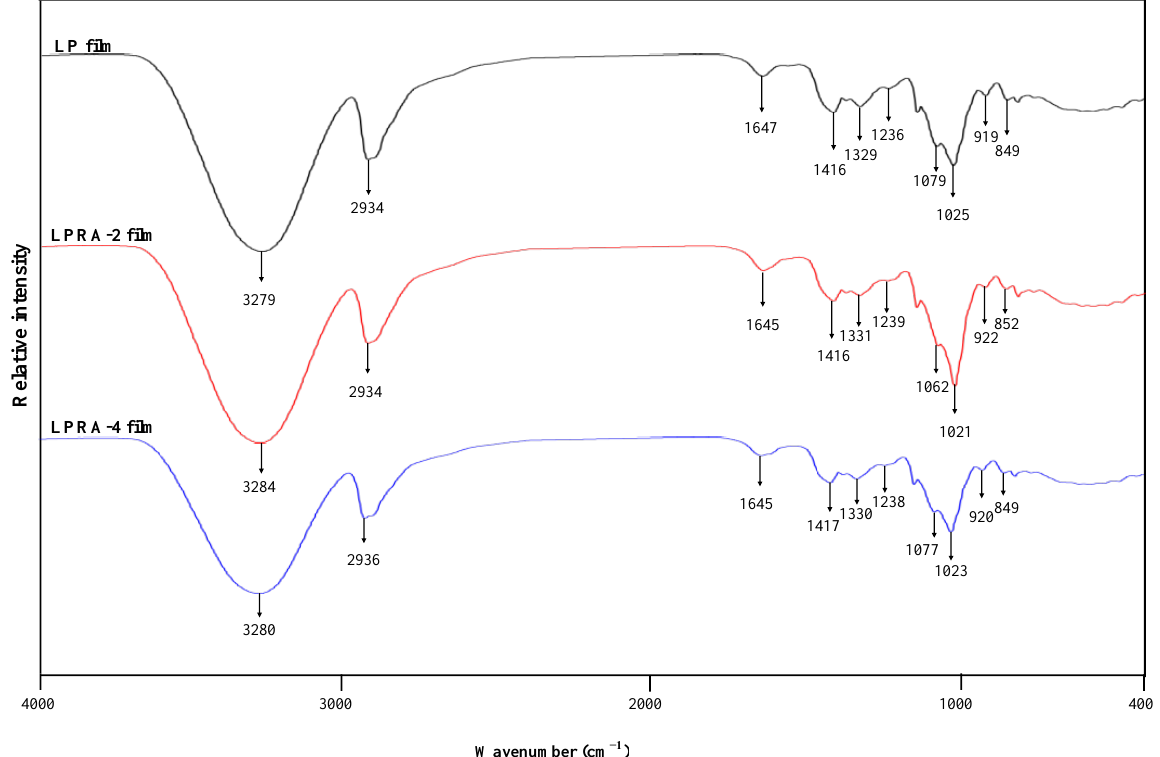
Figure 2. FT-IR spectra of LP film, LPRA-2 film, and LPRA-4 film.